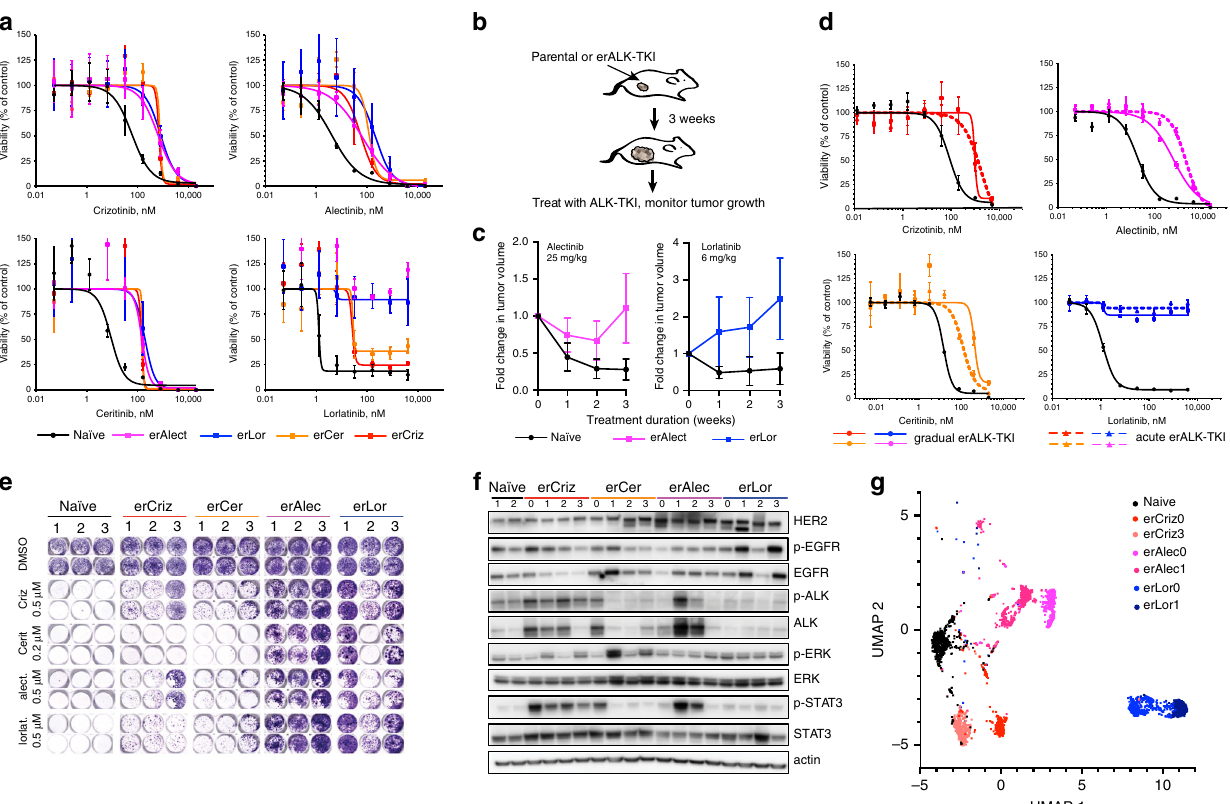
Fig. 1 Characterization of evolved resistance to ALK-TKIs. a Sensitivities of the treatment-naive H3122 cell line and its erALK-TKI derivative cell lines to the indicated ALK inhibitors, measured by Cell Titer Glo assay. Y-axis represents luminescent signal normalized to DMSO control. Mean ± SD of experimental triplicates are shown. b Experimental schemata of the xenograft experiment. Treatment is initiated after macroscopic tumors are formed within 3 weeks in the absence of therapies. c Growth dynamics of xenograft tumors initiated by inoculation of erAlect or erLor cells under treatment with indicated doses of ALK-TKIs or vehicle control. Mean± SD are shown ( n = 9 tumors for therapy naive, n = 6 tumors for each of the erALK cells). d Comparison of resistance levels of erALK-TKI cells evolved by gradual and acute drug exposure, measured by Cell Titer Glo assay. Mean ± SD of experimental triplicates are shown. e Sensitivity of independent derivates of erALK-TKI cells to the indicated ALK-TKIs, measured by crystal violet staining after 10 days of growing in the presence of indicated drugs. f Immunoblot analysis of the expression levels of the indicated proteins in the independent derivations of erALK-TKI cells, following 48 h growth in the absence of inhibitors to reduce their direct impact on cell signaling. “ 0 ” denotes gradually derived erALK-TKI cell lines, presented in a , “ 1 – 3 ” indicates independent derivate sub-lines obtained by acute selection for resistance in high drug concentrations, same as in e . Raw images shown in Supplementary Fig. 13. g UMAP analysis of single-cell RNA-seq expression of the indicated cell